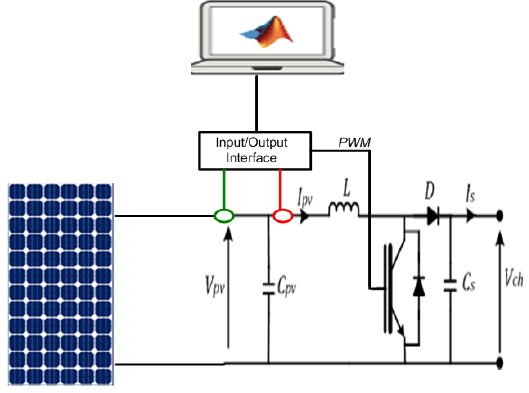
Figure 13. The proposed photovoltaic circuit. The synoptic of the power block of the synoptic test bench is presented in the following figure is represented by a DC / DC converter and the output inteface.